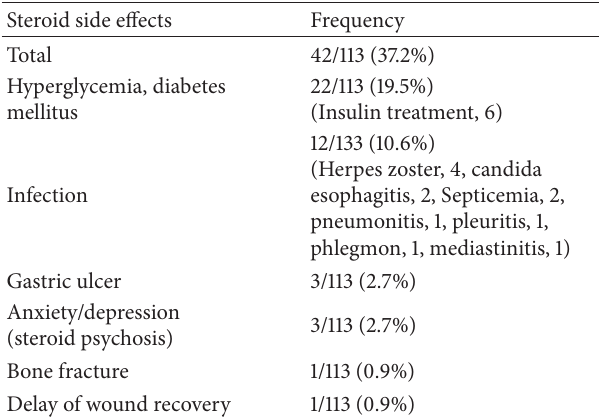
Table 3: Steroid side effects in the preoperative programmed high- dose steroid treatment